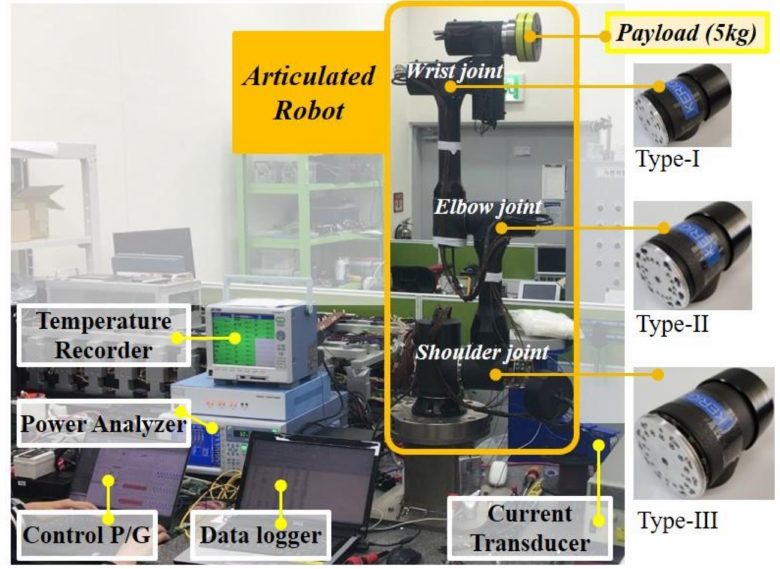
Figure 16. Performance test system for smart actuators applied to the